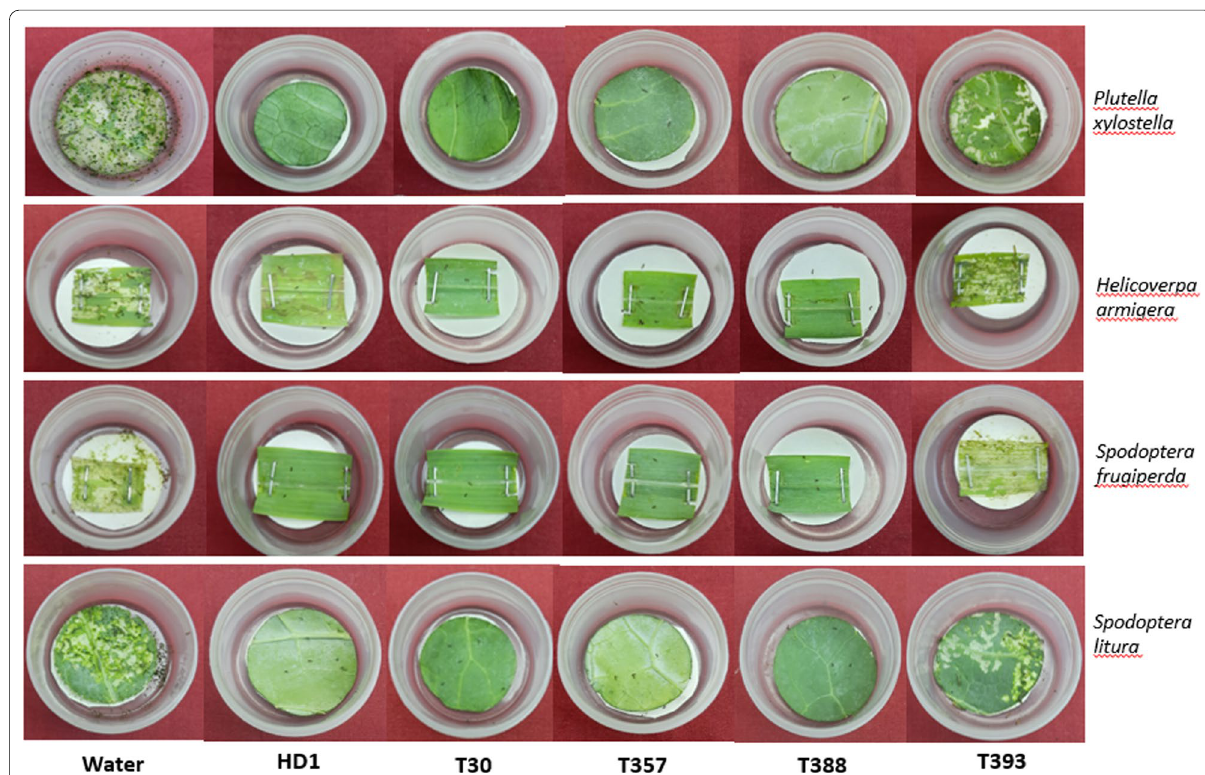
Fig. 6 In vitro insect bioassay with spore-crystal mixtures of Bt isolates against key lepidopteran pests. Negative control—water; positive control— HD1; toxic Bt isolates—T30, T357 and T388; non-toxic